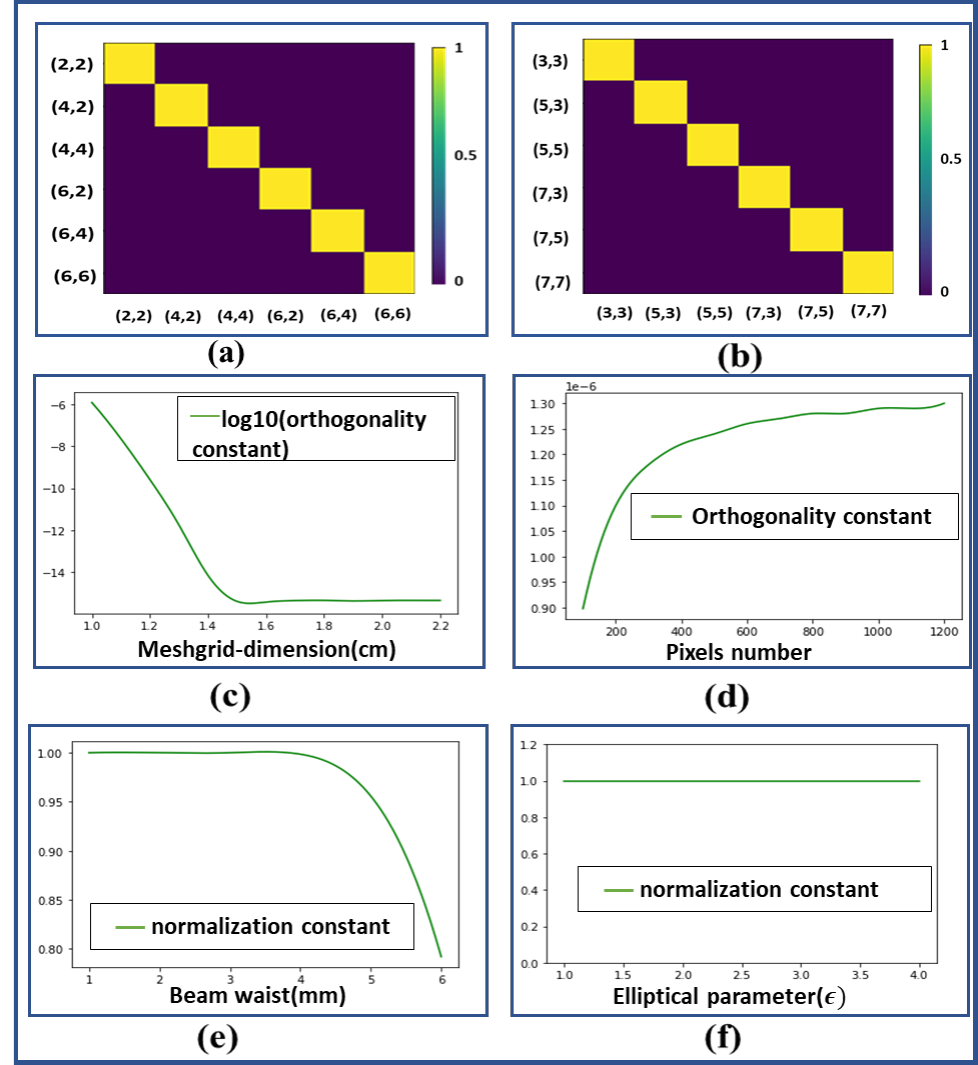
Figure 13. ( a ) Orthogonality relation between Ince–Gaussian beam of even indices for (cid:101) = 2. ( b ) Orthogonality relation between Ince–Gaussian beam of odd indices for (cid:101) = 2. ( c ) Variation ins log(orthogonality constant) for beams IG e tion in orthogonality constant for beams IG e in normalization constant for beams IG o normalization constant for beams IG o